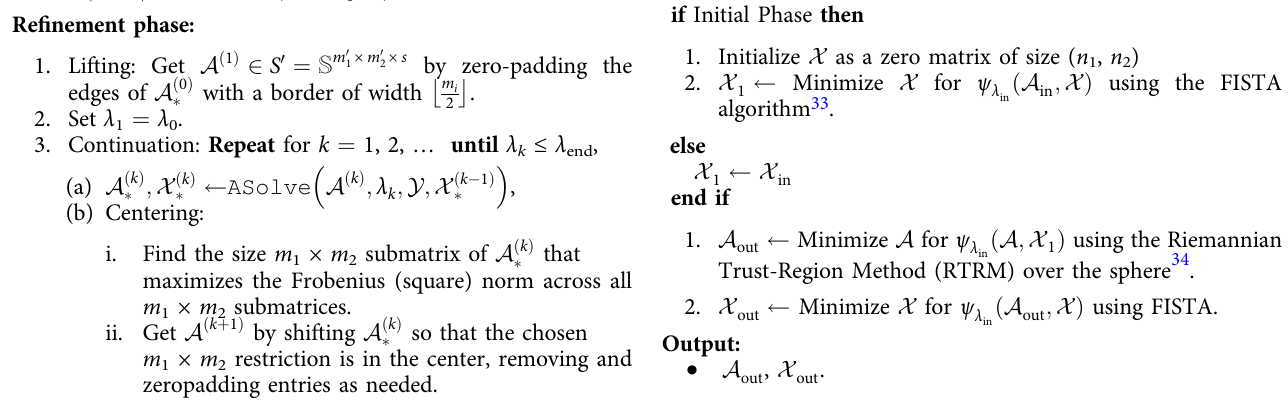
Algorithm 1 Complete SBD-STM procedure